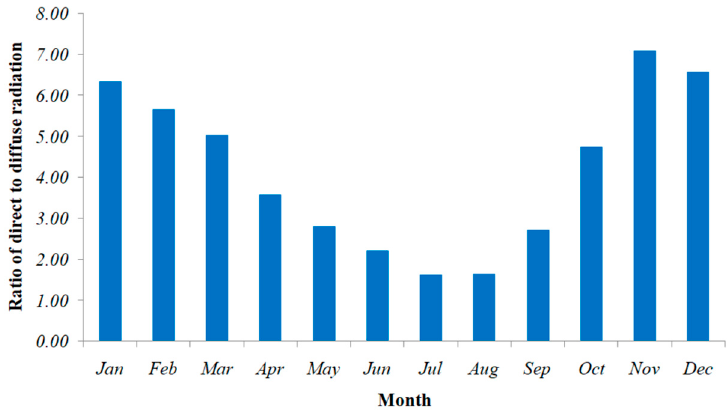
Figure 9. Ratio of direct to diffuse radiation of theselected location.